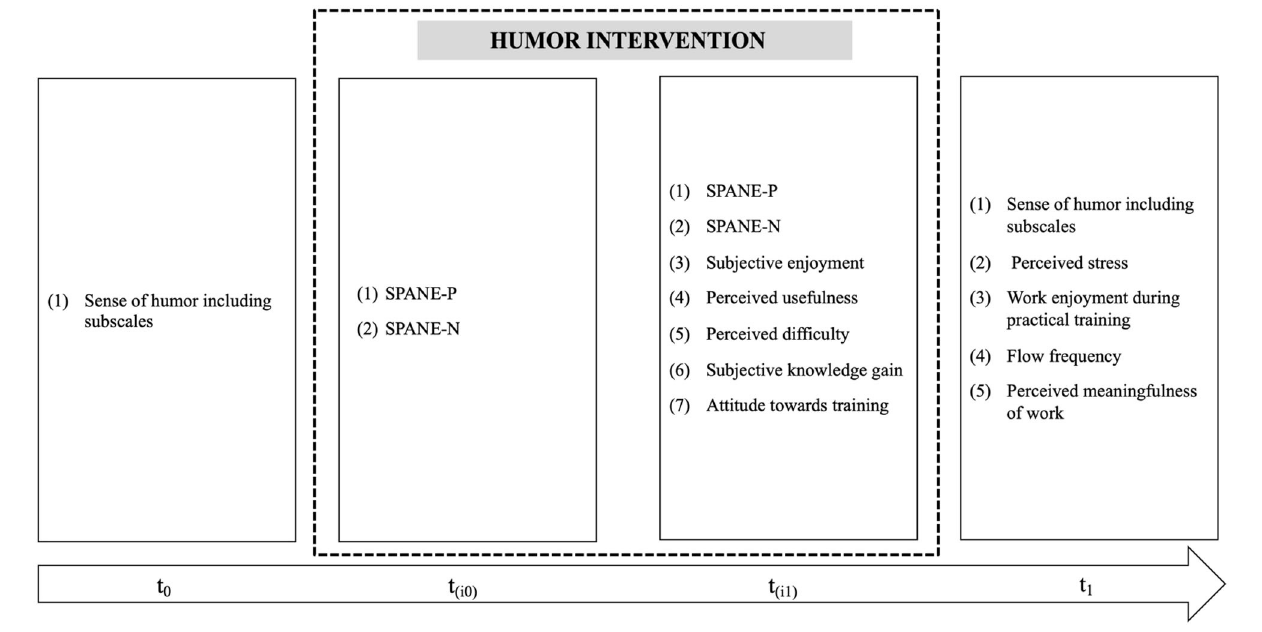
FIGURE 1 | Study variables and measuring points. Measuring points: t 0 = Baseline; t 1 = 6 months after the humor intervention; t (i0) = directly before the humor intervention; t (i1) = directly after the humor intervention; SPANE-P, positive affect; SPANE-N, negative